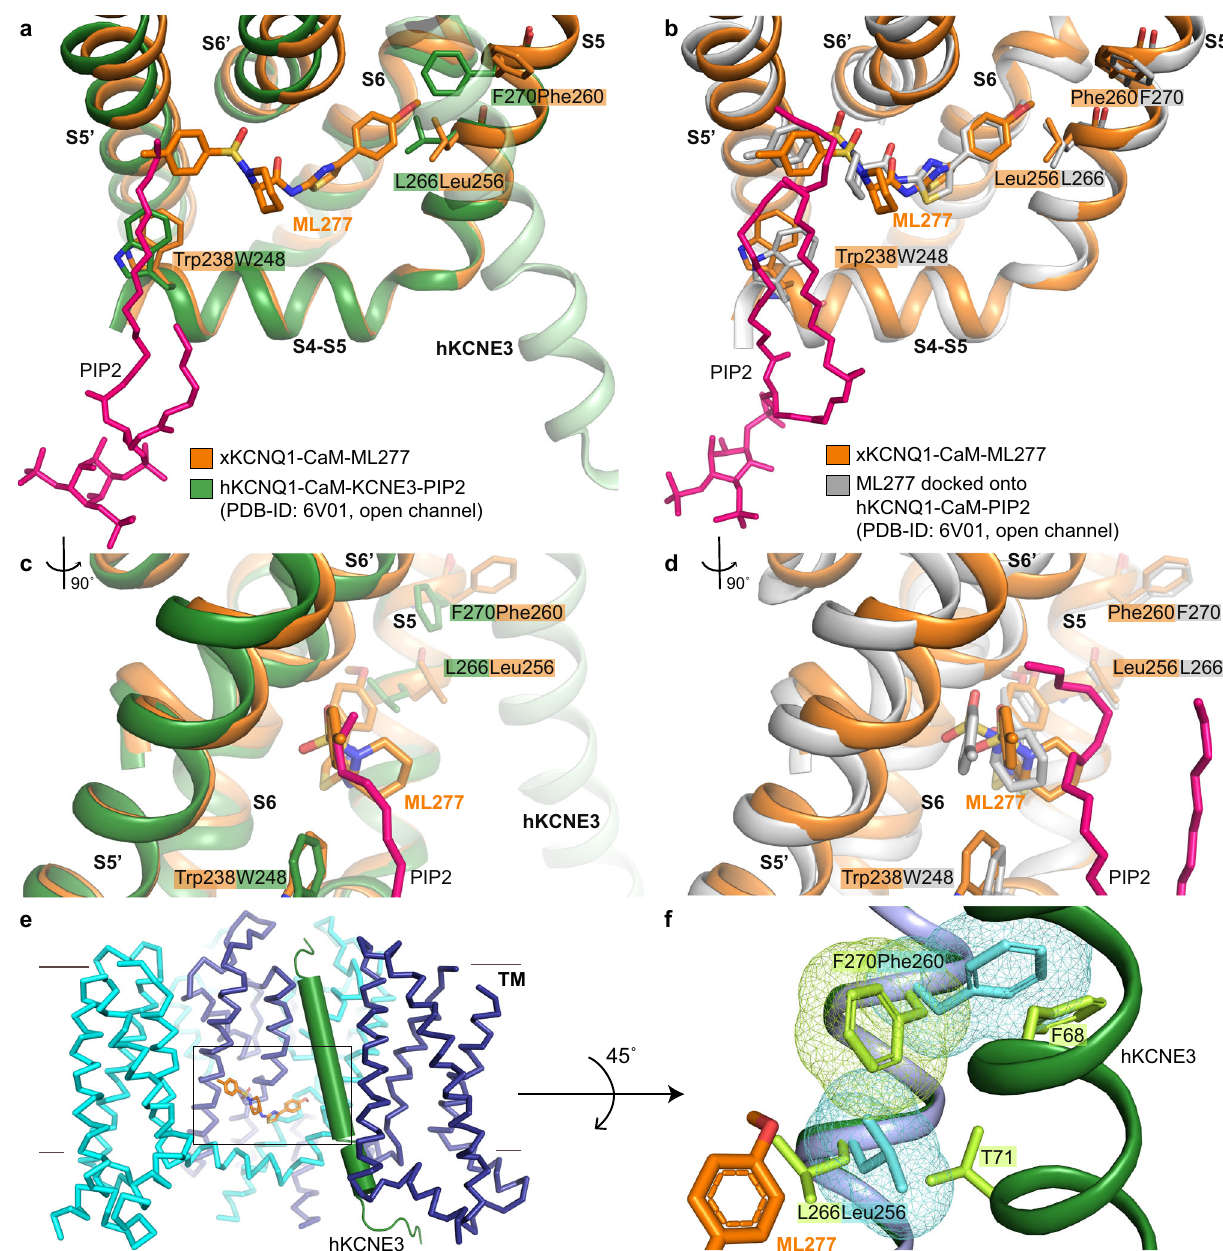
Fig. 4 ML277 binding to the open hKCNQ1 structure in the presence of PIP2 and KCNE3. a , c Superposition of xKCNQ1-CaM-ML277 structure (orange) onto the open pore hKCNQ1-CaM-KCNE3-PIP2 (PDB-ID: 6V01, green) via the S4-S5 linker and S5 helix. hKCNE3 is shown as pale green for comparison. c Side view of PIP2 tail and ML277. b , d Superposition of xKCNQ1-CaM-ML277 structure (orange) onto the modeled hKCNQ1-PIP2-ML277 structure (gray, PDB-ID: 6V01, KCNE3 was omitted). Binding free energy for ML277 was − 54.5 ± 0.65kcal/mol. d Side view of PIP2 tails and ML277. e Superposition of KCNE3 (green) from hKCNQ1-CaM-PIP2-KCNE3 (PDB-ID: 6V01), onto the xKCNQ1-CaM-ML277 complex (cyan and blue). f Conformations of T71 and F68 in KCNE3 and F270 in hKCNQ1 do not allow L266 to rotate and ML277 to bind. Residues on KCNQ1-CaM-PIP2-KCNE3 (green) are lime green and corresponding residues Leu256 and Phe260 in xKCNQ1-CaM-ML277 are shown in cyan. VDW surfaces of Leu256, Phe260 in xKCNQ1, and F270 in hKCNQ1 are shown as mesh to indicate potential